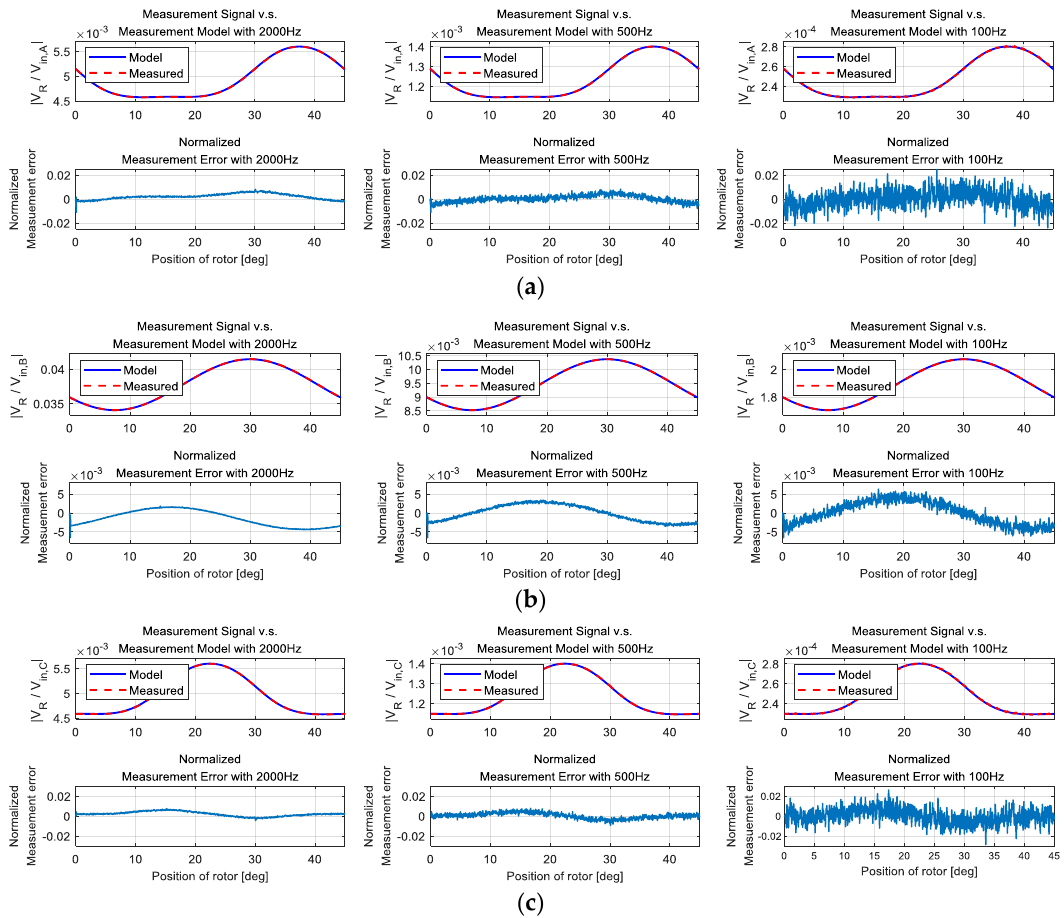
Figure 14. Comparison of the measurement signal and measurement model: ( a ) when v in,A is excited, ( b ) when v in,B is excited, ( c ) when v in,A is excited.